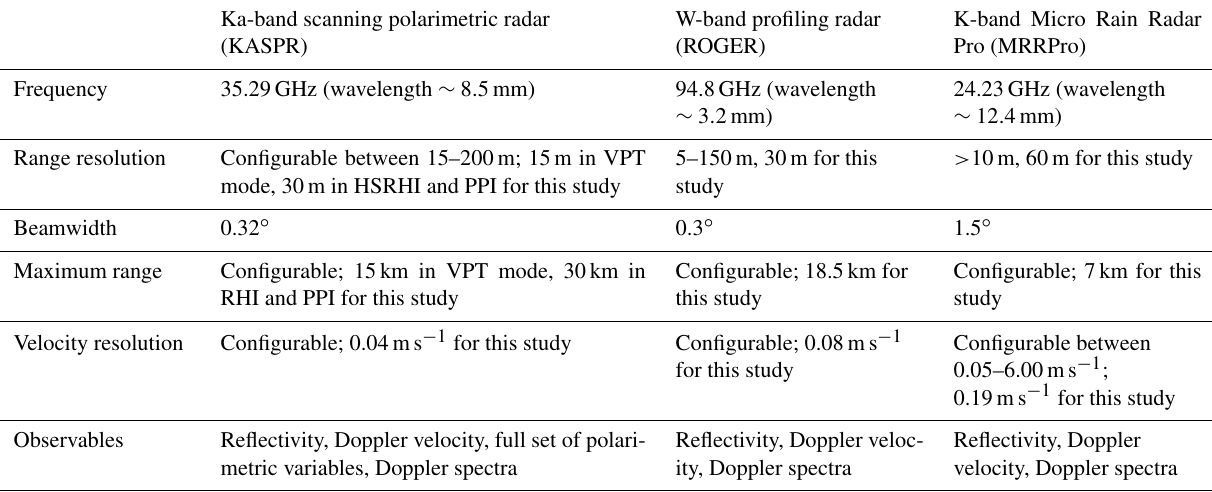
Table 1. Specifications for KASPR, ROGER, and